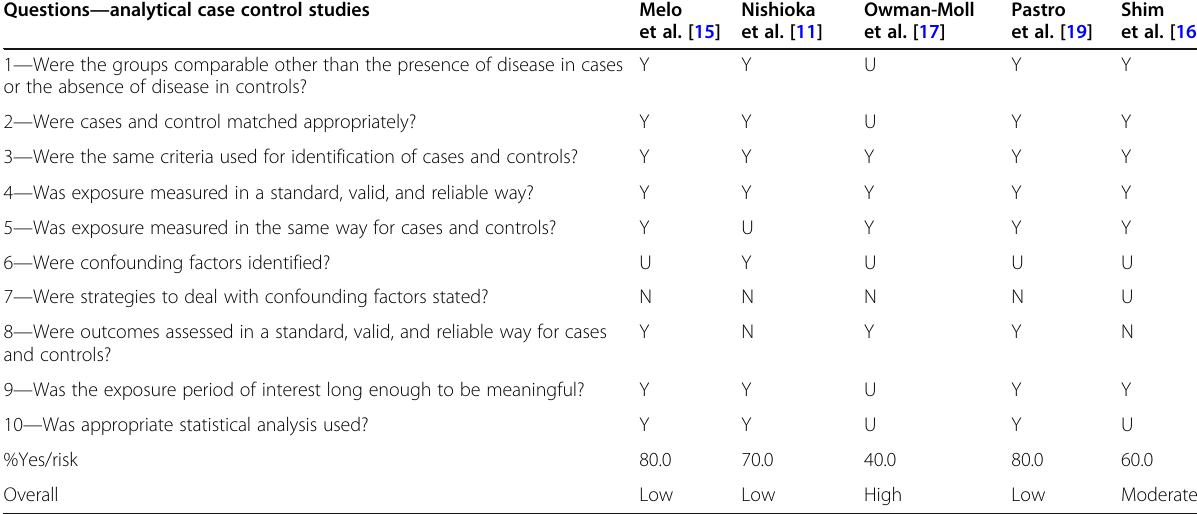
Table 3 RoB of case control studies in the qualitative synthesis based on the Joanna Briggs Institute Critical Appraisal Checklist Questions — analytical case control